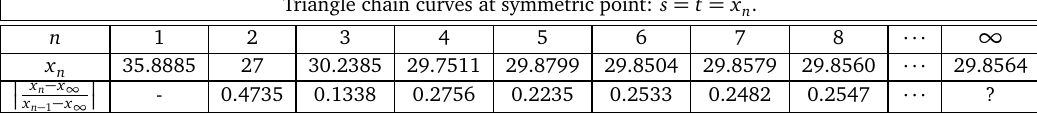
Table 2: Accumulation of Landau curves at finite s and t . The table lists the symmetric point ( s = t ) of the first few Landau curves produced by the infinite set of triangle chain diagrams (depicted in black in figure 5). The curves accumulate towards the red curve in figure 5. The last row of the table indicates that the approach towards the limiting curve is very quick (approximately